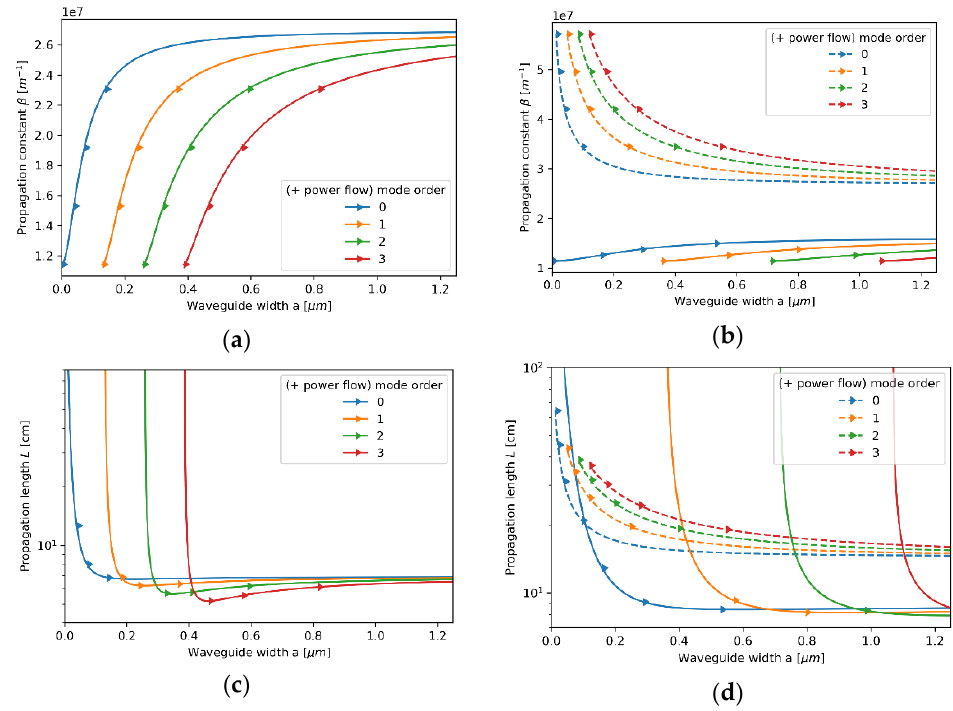
Figure 9. Propagation constant ( a , b ) and propagation length ( c , d ) of TE modes plotted versus waveguide width for an HMM waveguide with Nb2O5 layer of t Nb2O5 = 110 nm embedded in the unit cell and described with local ( a , c ) and nonlocal EMT ( b , d